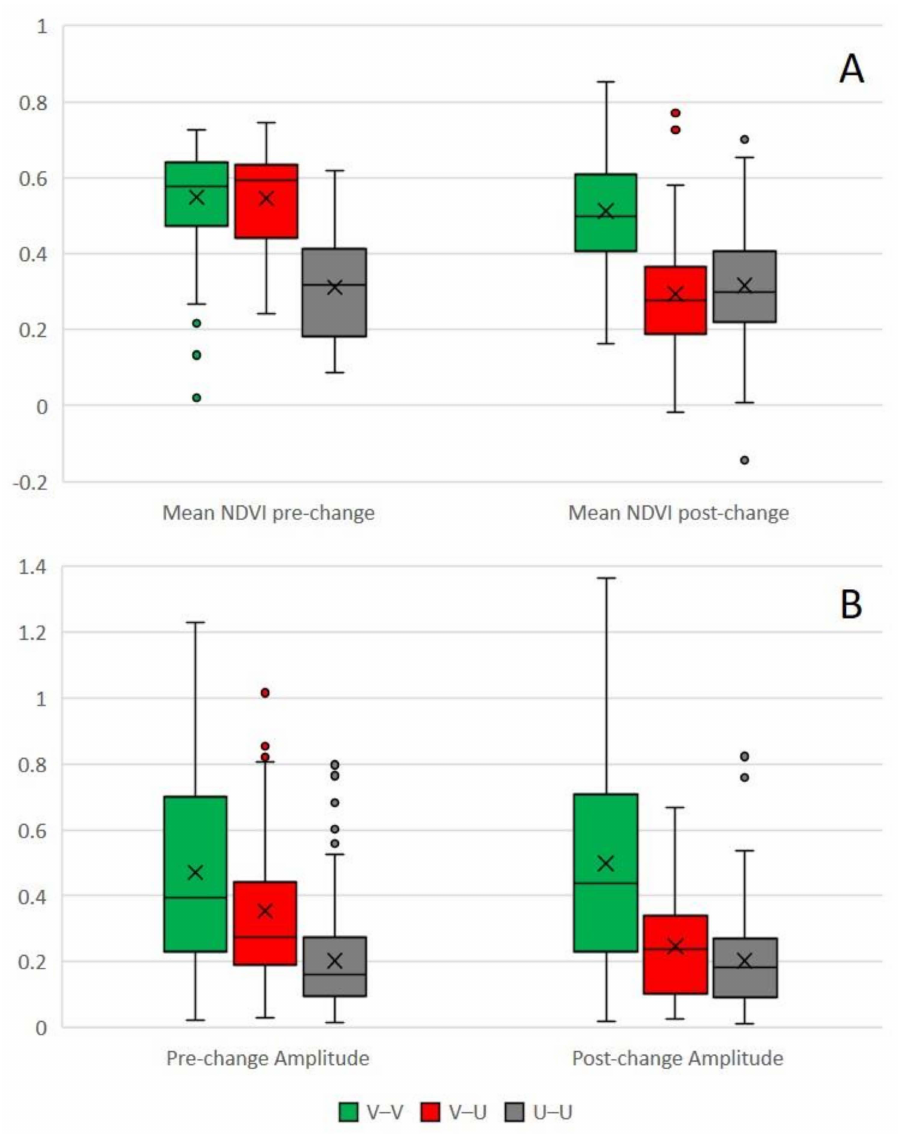
Figure 8. Box plots of the parameters of the training data (Set C) used to classify the type of change. ( A ) Mean value of the NDVI trend before and after change, ( B ) amplitude before and after